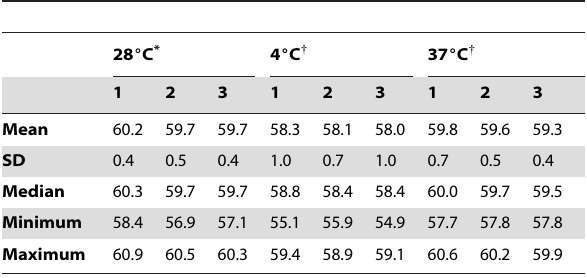
Table 3. Effect of ambient temperature on stability and reproducibility of reaction temperature in NINA heaters.